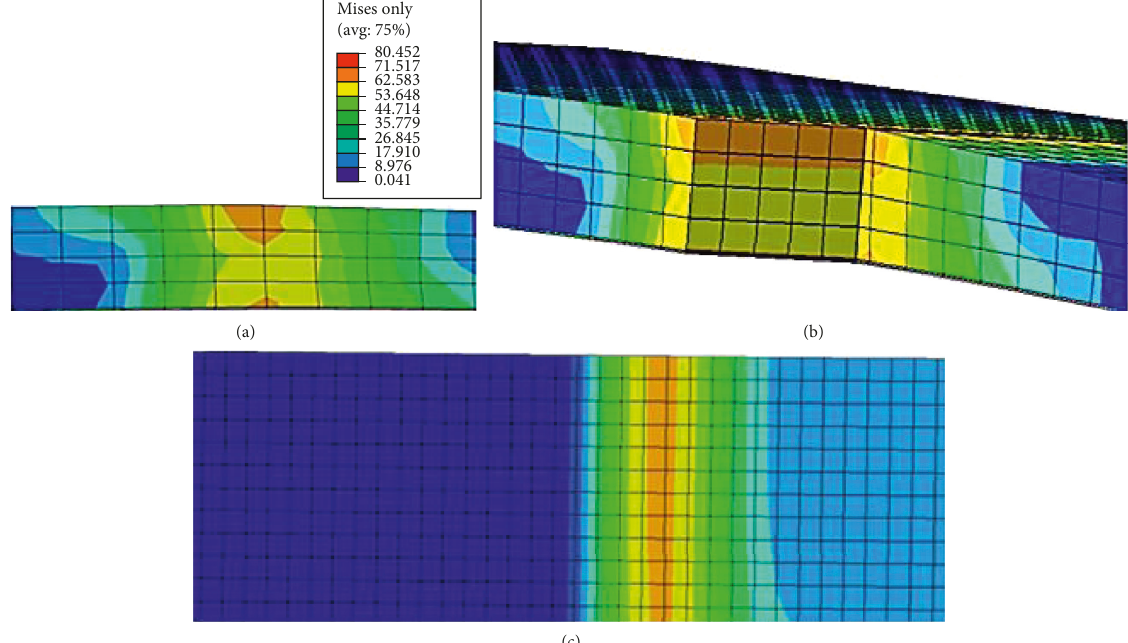
Figure 14: The distribution of equivalent stresses in the thermal deformation hearth (a, b) and in the contact zone of the tapes with the surface of the part (c) in the case of electrocontact surfacing of the steel tape at K v